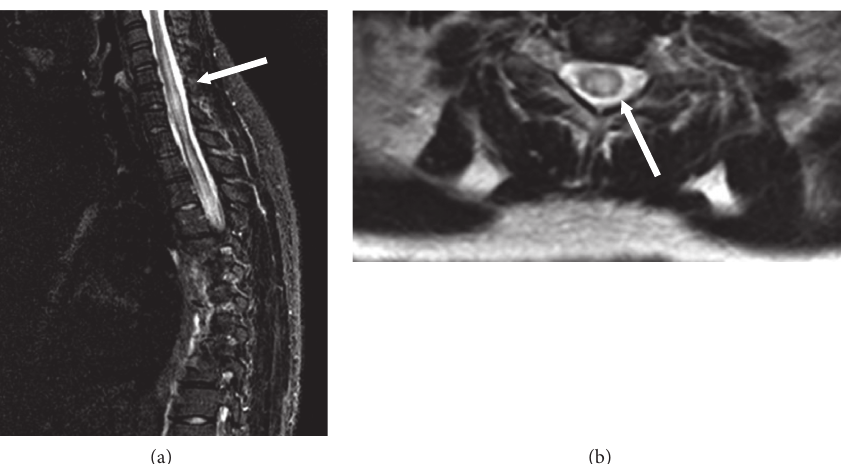
Figure 1: Initial MRI of the cervical and thoracic spine. (a) Sagittal short tau inversion recovery (STIR) image shows increased signal intensity of the spinal cord beginning at C4 with caudal extension into the thoracic spine. (b) T2-weighted axial image at the C4 level demonstrates increased central signal intensity of the spinal cord.